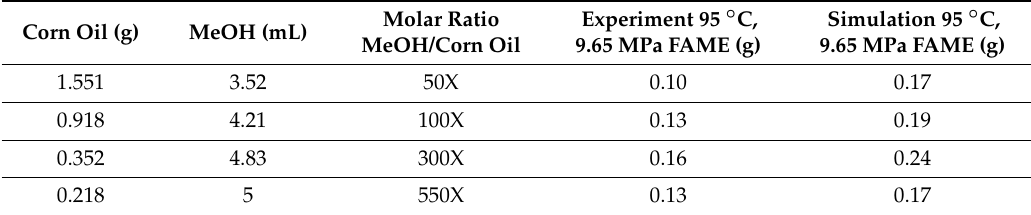
Table 1. Experimental and Simulated Methyl-Oleate Yield (g) using Methanol/TG Molar Ratios at 95 ◦ C, 9.65 MPa.